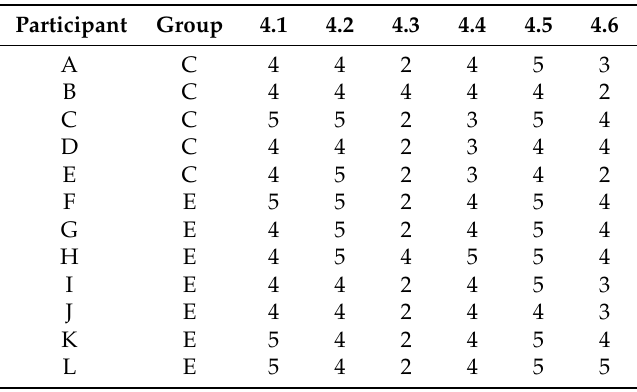
Table A11. Post-survey section results